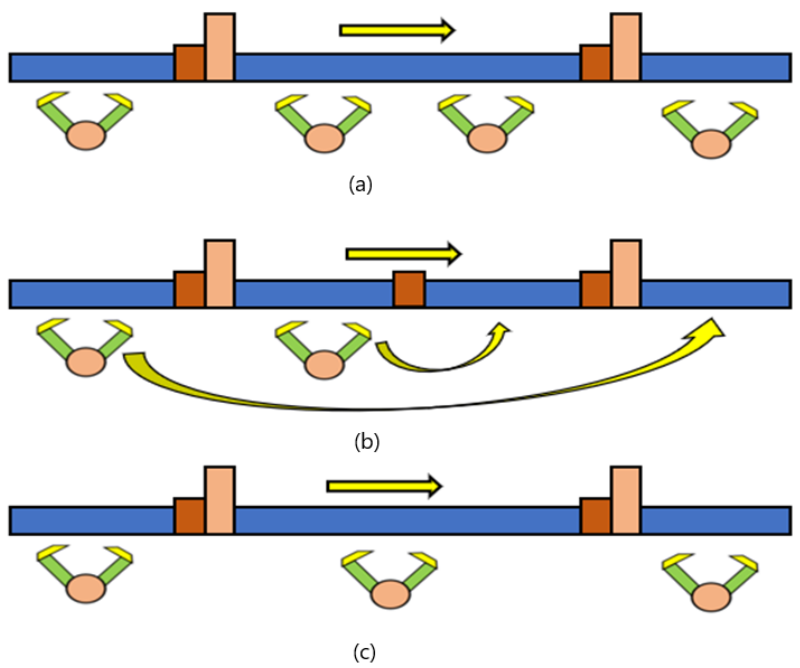
Figure 5. Variants to adapt the assembly compared to the initial situation ( a ) to the decrease in the assembly cadence ( b , c ).